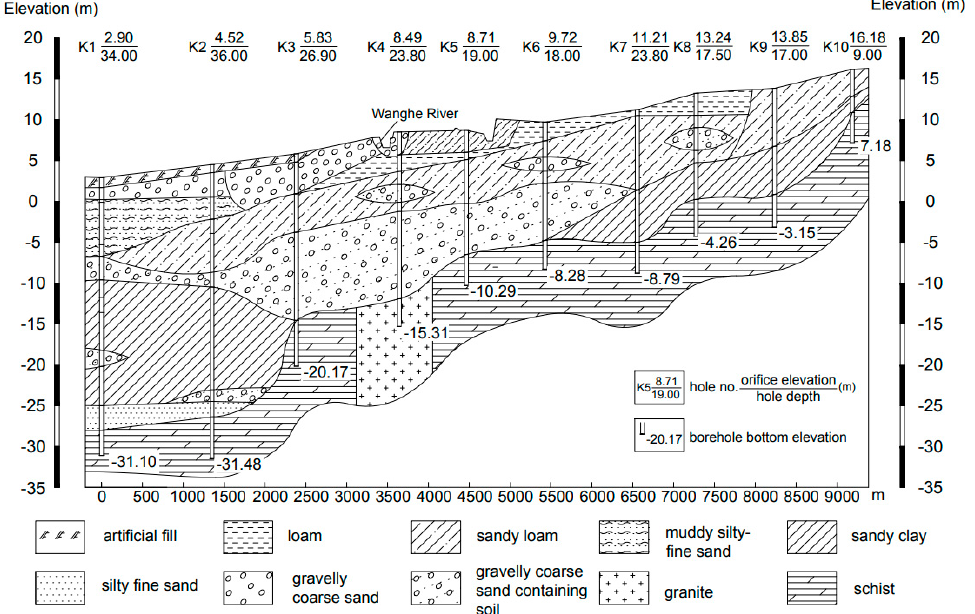
Figure 8. Hydrogeological section of the storage layers (line A-A’ in Figure 3).